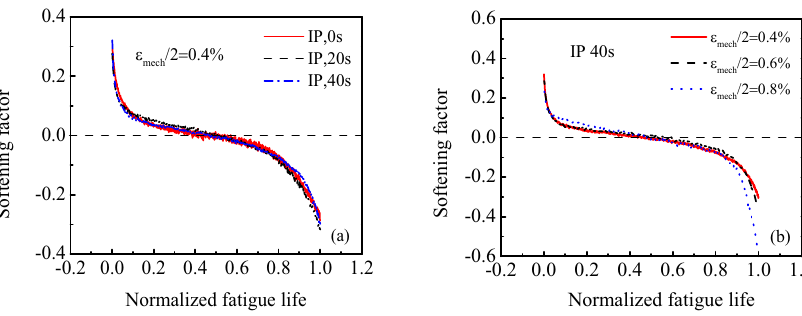
Figure 6: The change of softening factor with fatigue life ( a ) under di ff erent hold time and ( b ) at di ff erent mechanical strain